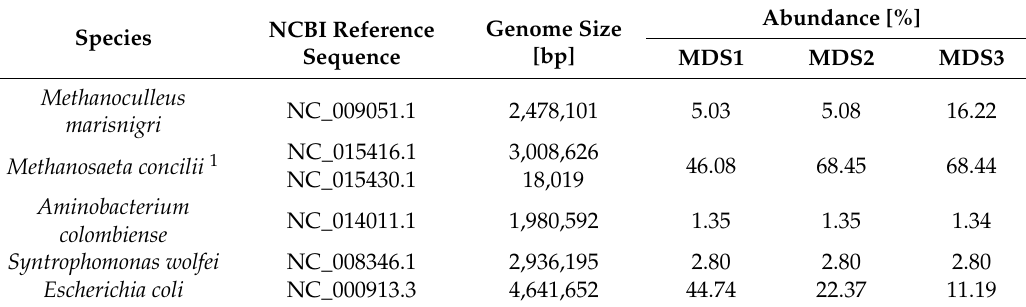
Table 1. Composition of metagenomic mock data